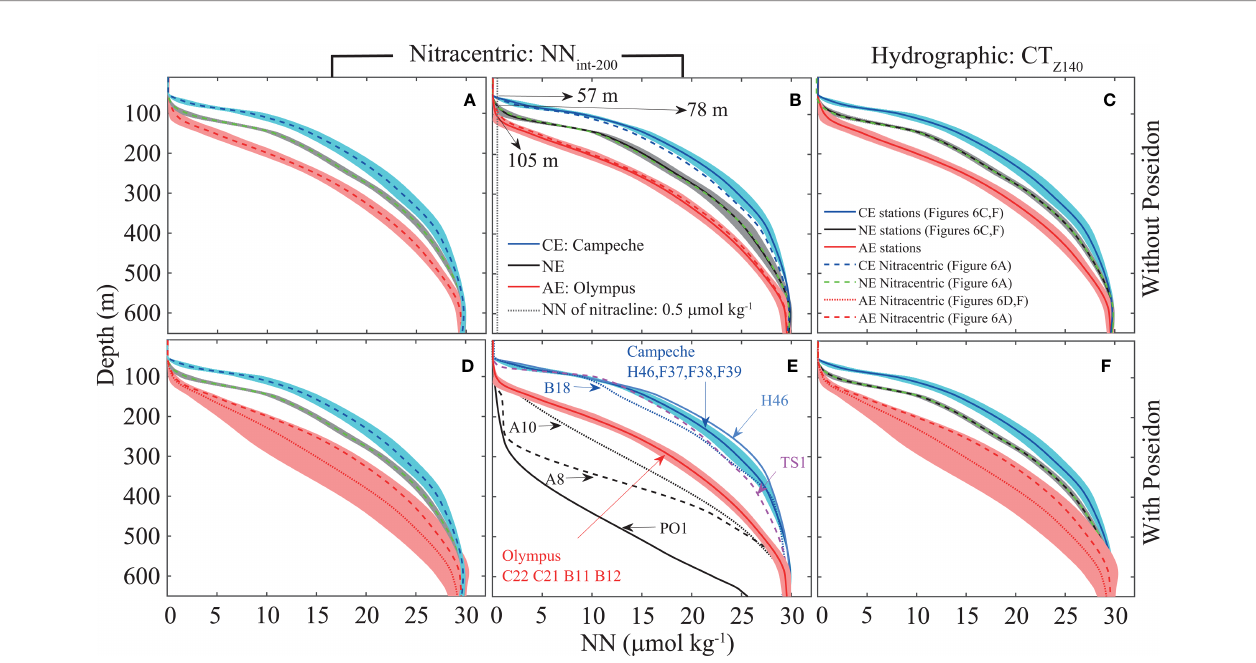
FIGURE 6 | Average of the nitrate + nitrite (NN, µmol kg -1 ) depth pro fi les with 95% con fi dence intervals (CIs) for cyclonic (CE; blue-cyan), no eddy (NE; black-green), and anticyclonic (AE; red-pink) groups obtained by both nitracentric (left and central panels) and hydrographic (right panel) classi fi cations without (A – C) and with (D – F) the Poseidon stations. (B) Average of the nitrate + nitrite (NN) depth pro fi les (± SD) for the Olympus stations (B11 - B12, C20 - C22; red), some Campeche stations (F37 - F39, and H46; blue), and some NE stations (A3-A4, B13, D28, D30, and F36; black). (E) The same CE and AE groups as in (B) but including the vertical pro fi les of the Poseidon stations and the three stations of the CE group (H46, B18, and TS1). The thick blue, black, and red lines are the means of the CE, NE, and AE groups, respectively. In (A – D, F) , the blue (CE), green (NE), and red (AE) dashed lines are the NN means in (A) . The dotted red line is the NN mean of the AE group in (D) . The values in panel (B) indicate the nitracline depth, which was de fi ned as the depth at which a concentration of 0.5 µmol kg -1 is observed (Cianca et al., 2007; Linacre et al.,